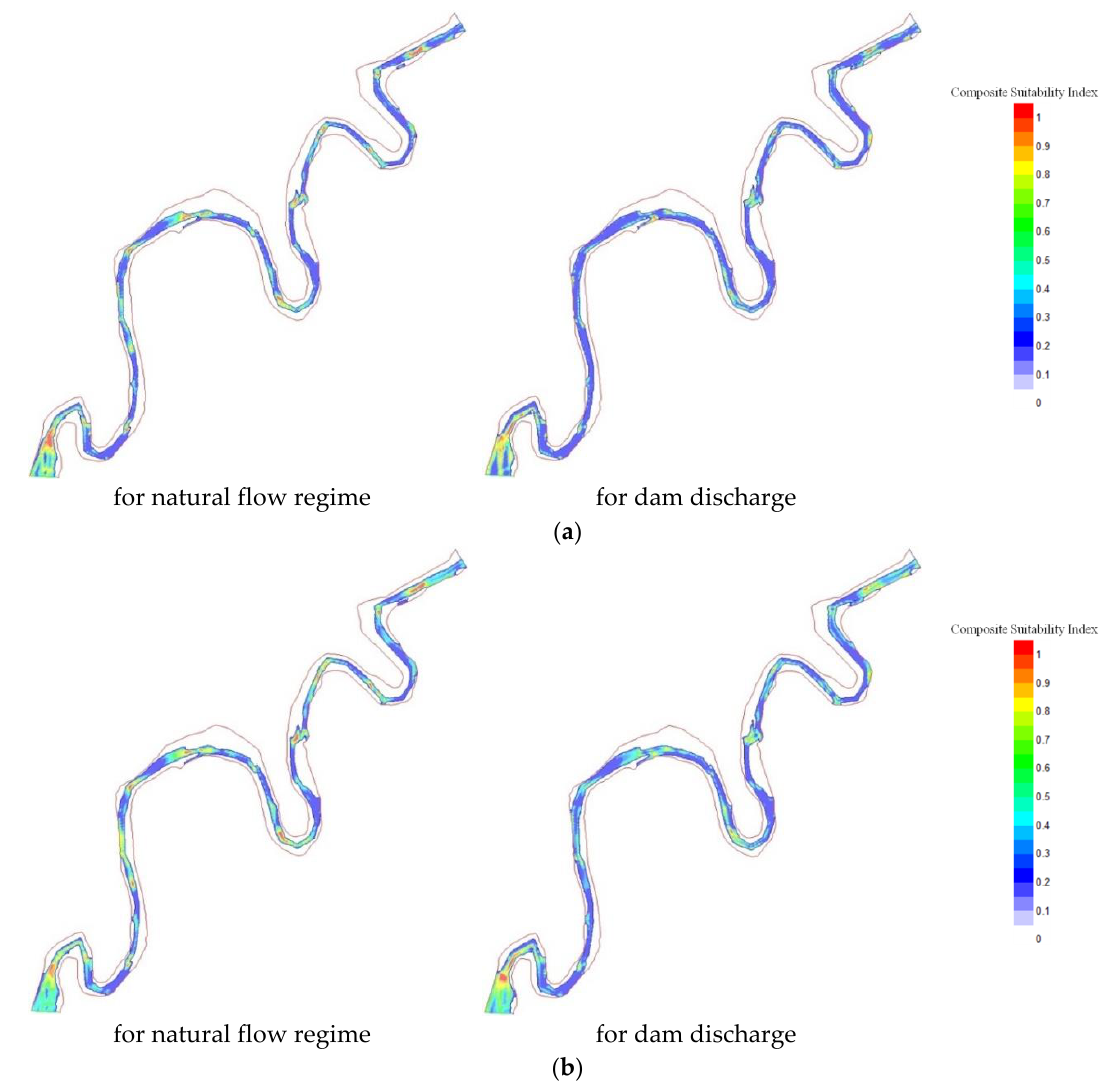
Figure 6. The composite suitability index (CSI) distributions for the target species: ( a ) Zacco platypus and ( b ) Baetis fuscatus .